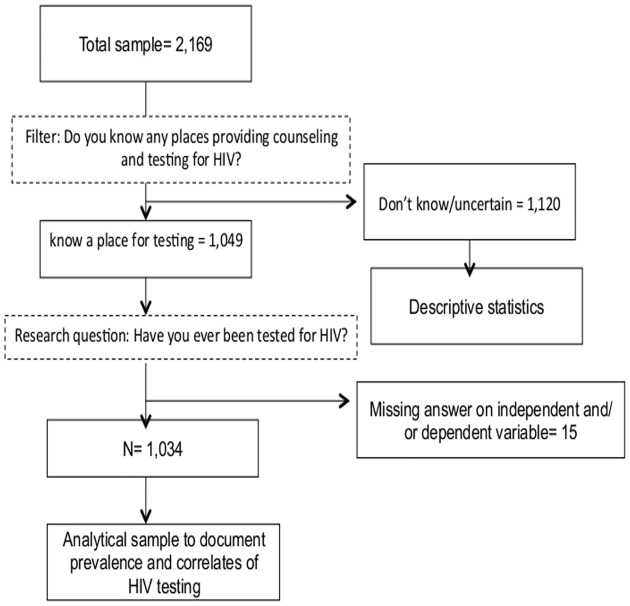
Flow of the data analysis.